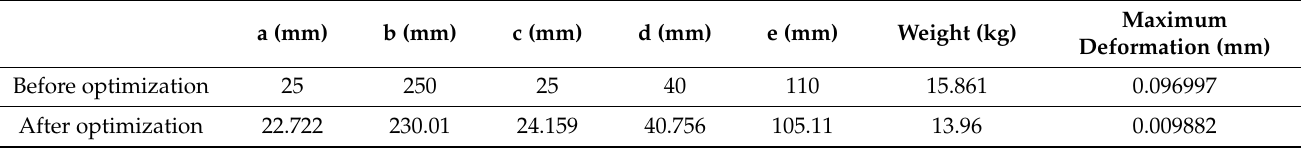
Table 4. Parameter values of lightweight drive rod before and after optimization.